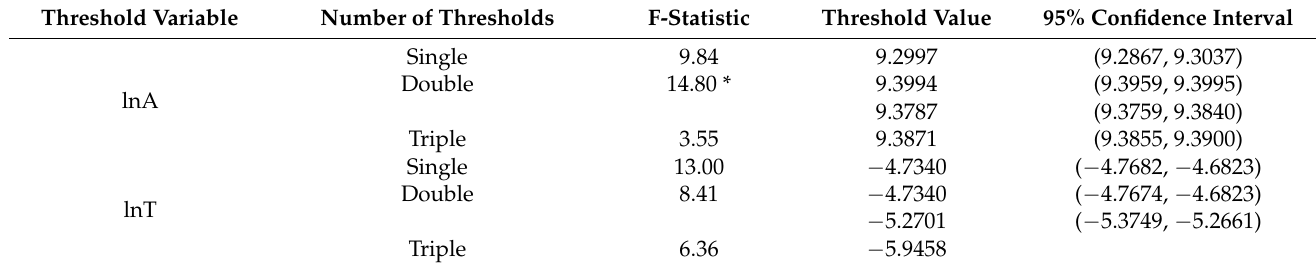
Table 3. Tests for threshold effect and threshold value estimation of the central region.